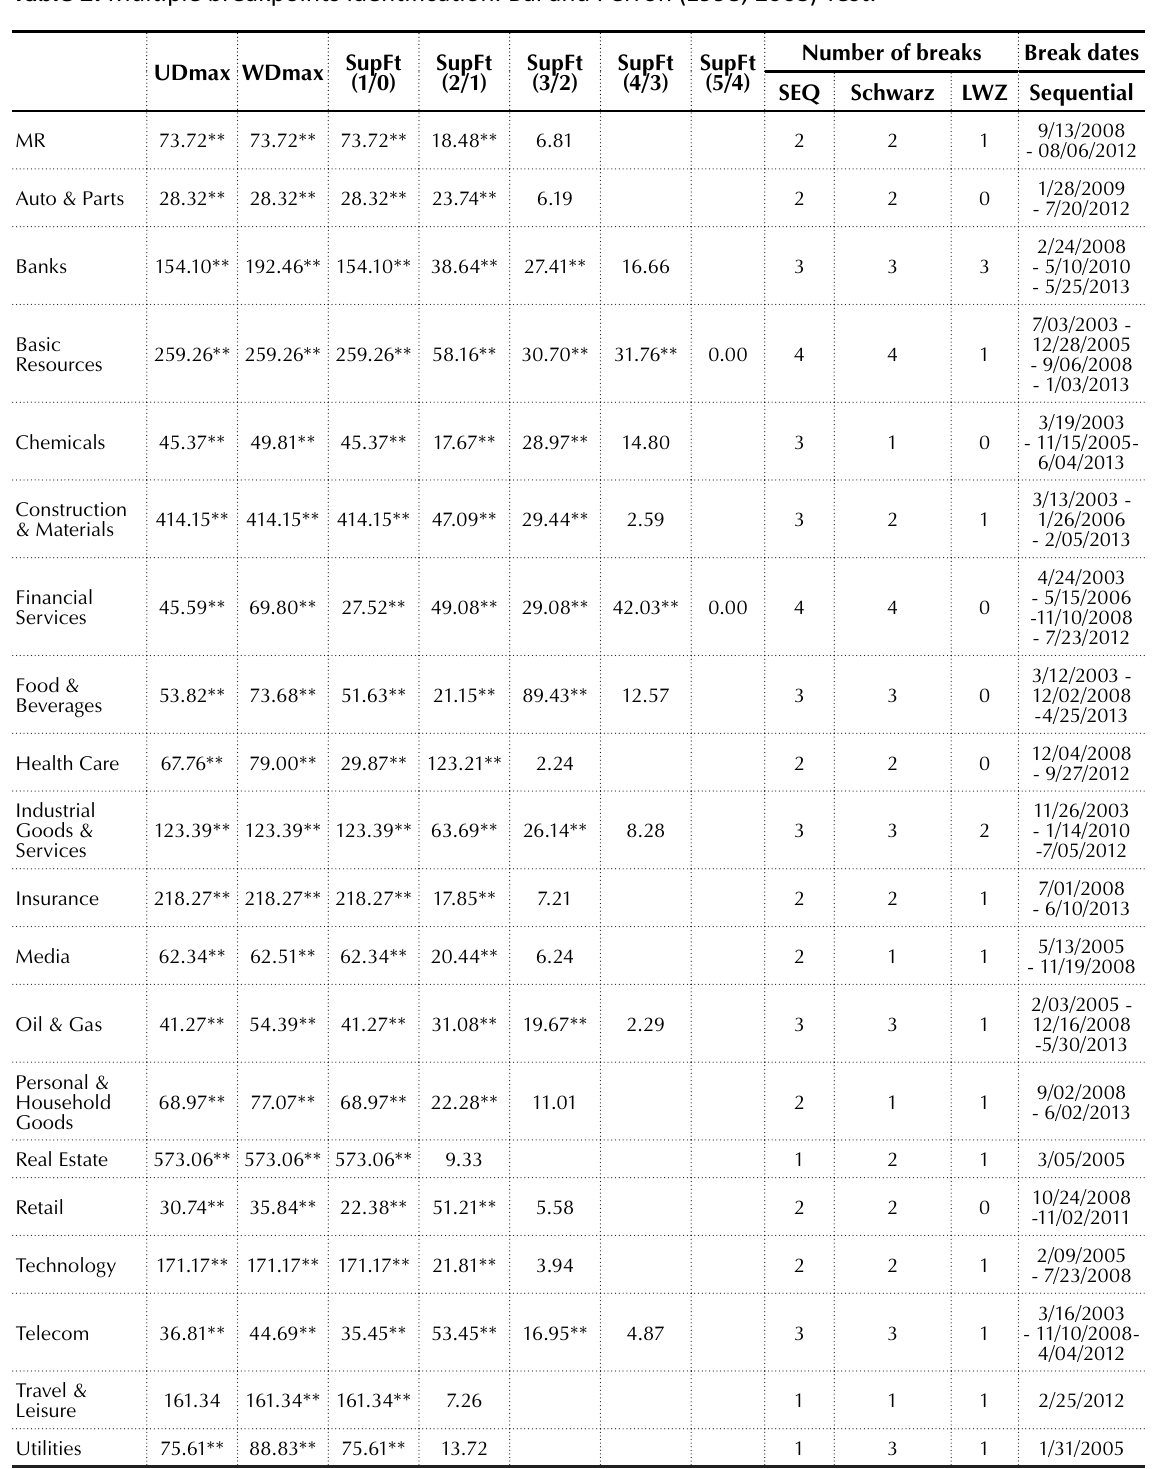
Table 2. Multiple breakpoints identification: Bai and Perron (1998, 2003)